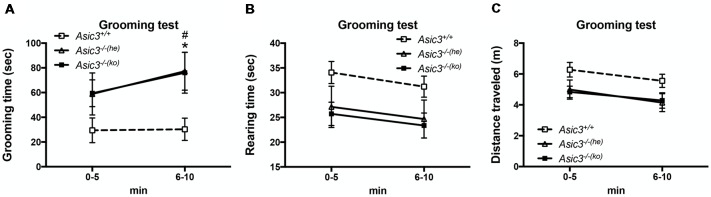
Increased self-grooming behavior in novel cage in Asic3−/− mice. (A) The self-grooming behavior was increased in Asic3−/− mice born to heterozygous dam (Asic3−/−(he)) and knockout dam (Asic3−/−(ko)). Data represent mean ± SEM. Genotype: F(2,39) = 4.109, p = 0.0240; Time: F(1,39) = 1.958, p = 0.1697; interaction: F(2,39) = 0.4408, p = 0.6467; Post hoc analysis: *p < 0.05 Asic3+/+ vs. Asic3−/−(he), #p < 0.001 Asic3+/+ vs. Asic3−/−(ko). (B) No change in the rearing behavior in the novel cage in Asic3−/− mice. (C) No change in the distance traveled in the novel cage in Asic3−/− mice. N = 13–15 mice per group. Data represent mean ± SEM. Data analyzed by two-way ANOVA.